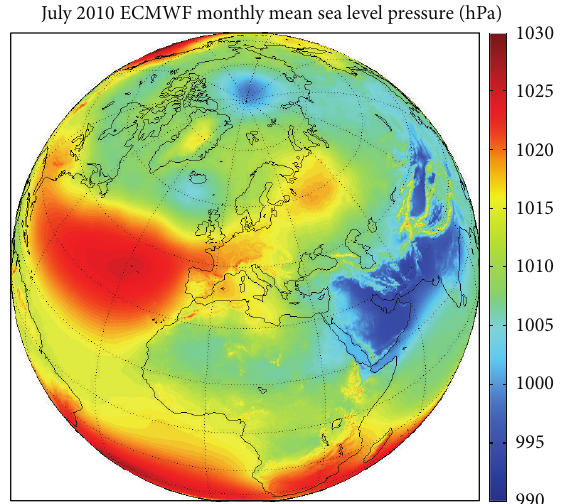
Figure4:ECMWFanalysisofthemonthlysealevelpressureforJuly 2010.